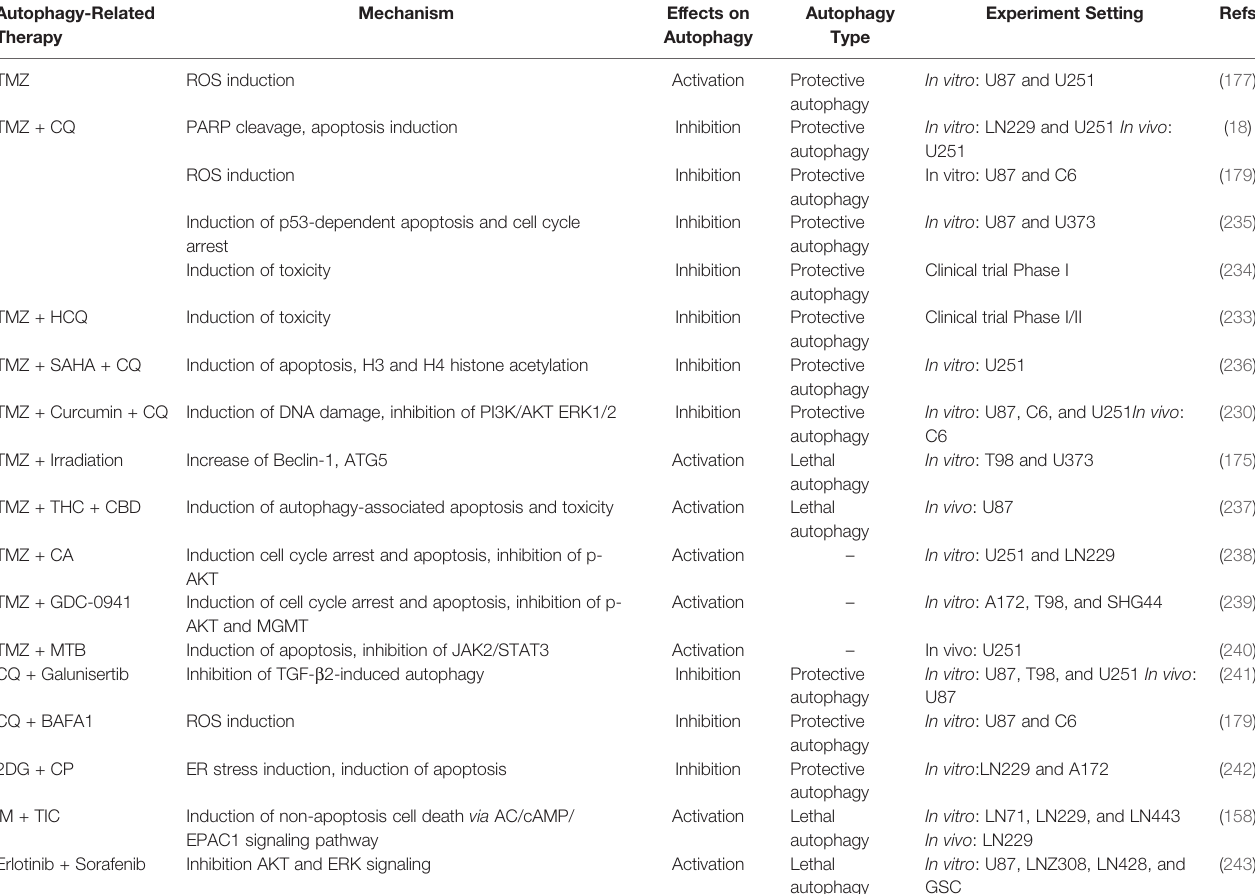
TABLE 1 | Autophagy-related therapy against glioma. Autophagy-Related